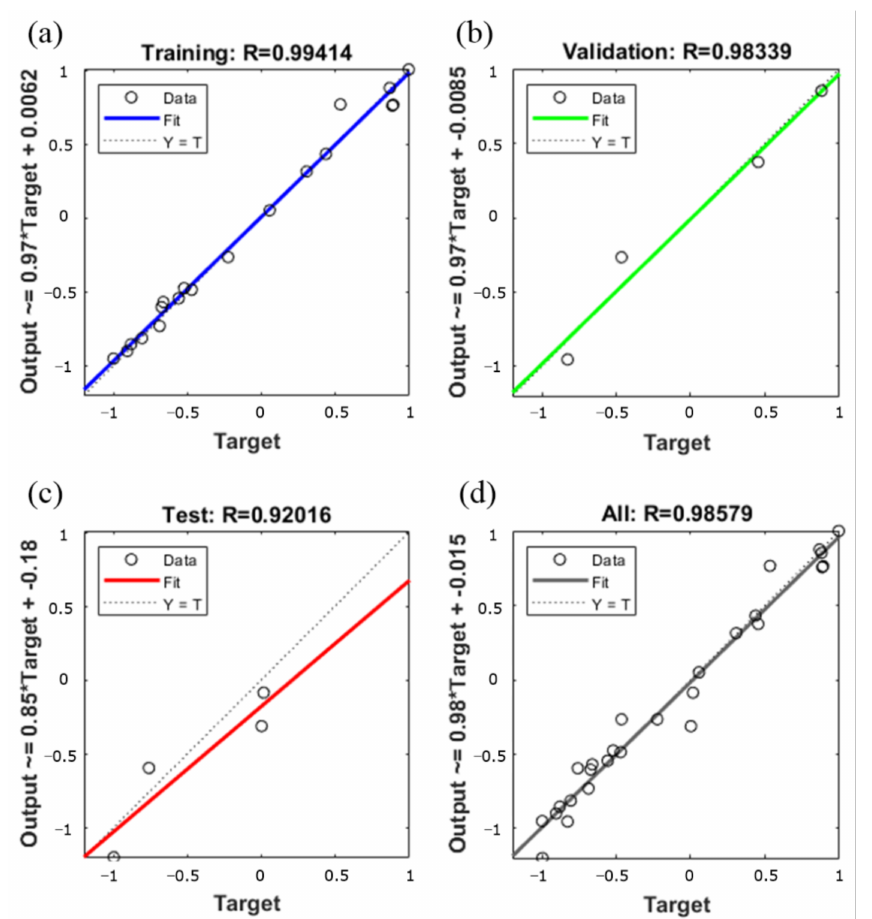
Figure 20. The results of multivariate regression analysis. ( a ) Training data ( b ) Validation data ( c ) Test data ( d ) All